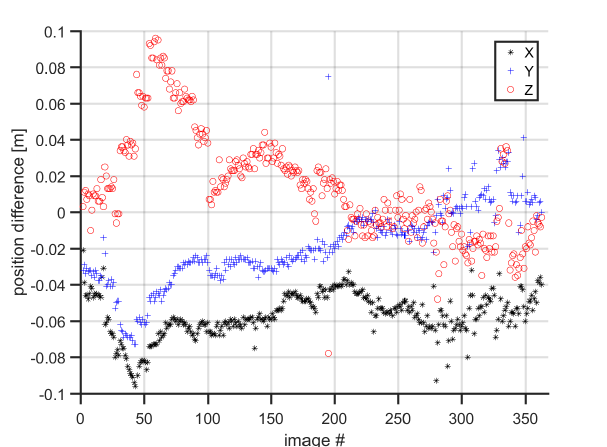
Figure 4. Differences in absolute camera positions between high- end and low-cost L1 only (ambig. float) GNSS